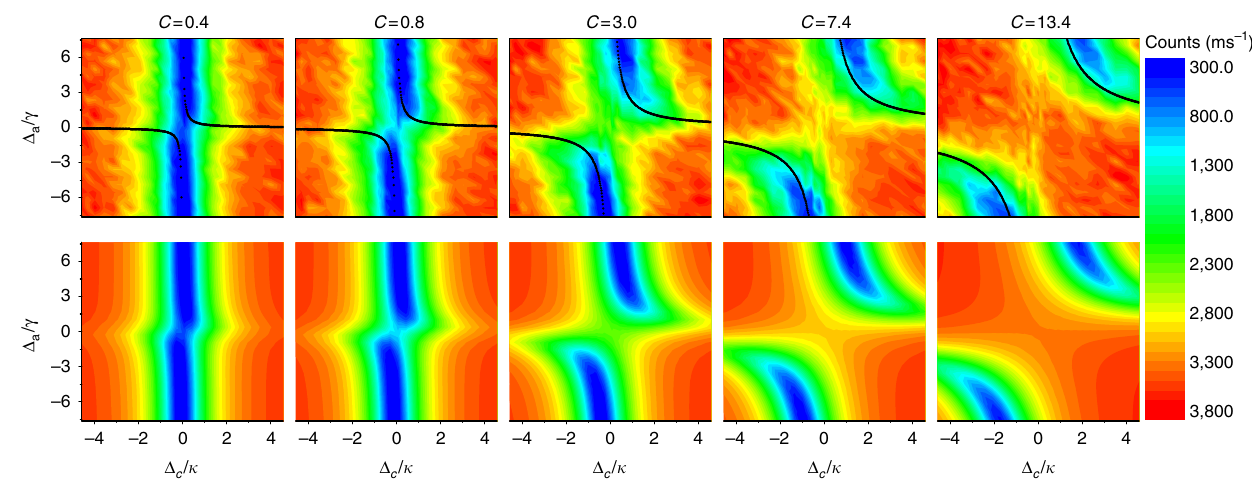
Figure 3 | Probing the system by driving the cavity mode. Two-dimensional scans of the cavity reflection signal in the configuration of Fig. 2a as a function of the detuning from the cavity ( D c ) and from the atomic ( D a ) resonances for different values of the cooperativity C . Upper row: experimental spectra. Note that the axes are normalized to the respective damping rates. The colour scale indicates the measured number of counts per ms. Every spectrum contains 28 (cid:7) 28 points, each averaged over 40 experimental realisations. The black curves show the eigenvalues of the undamped Hamiltonian. Lower row: theory of equations (6) and (8) after fitting to the data in the upper row. The fitting parameters are C and the off-resonant